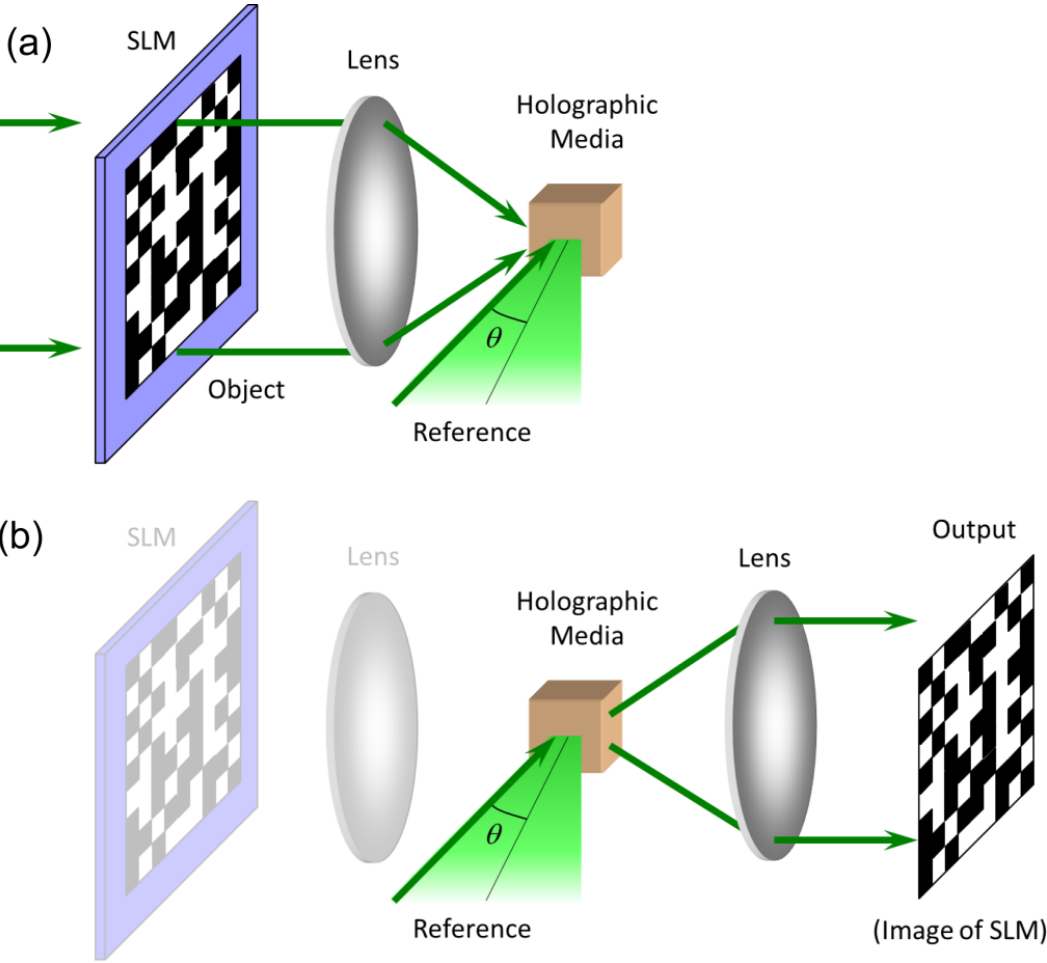
Figure 1. The holographic data storage ( a ) recording and ( b ) reading